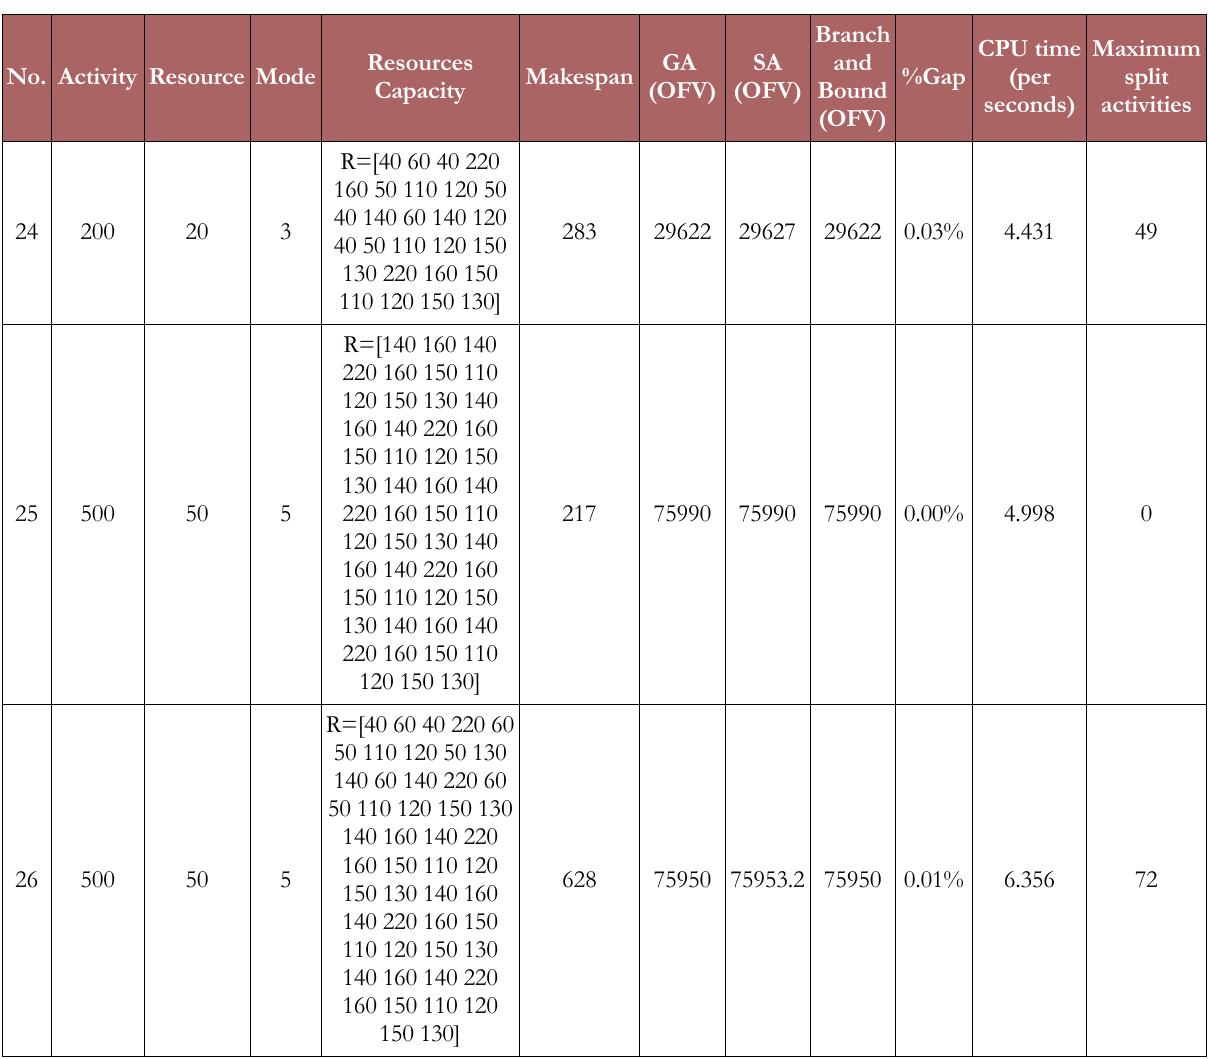
Table 2. Results of solving experiments derived from the